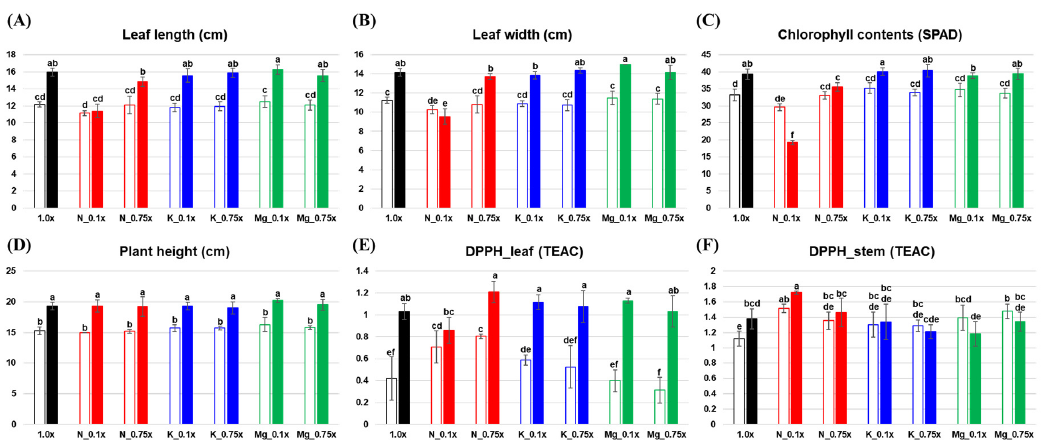
Figure 1. Leaf length ( A ), leaf width ( B ), chlorophyll content ( C ), plant height ( D ), and antioxidant activity ( E , F ) under different mineral conditions in Perilla frutescens . Empty bars represent 10 days of low mineral supply, and filled bars represent 21 days of low mineral supply. Different letters indicate significant differences according to Duncan’s multiple-range test by analysis of variance (ANOVA, p -value < 0.05). TEAC: trolox equivalent antioxidant capacity; N: nitrogen; K: potassium; Mg: magnesium.